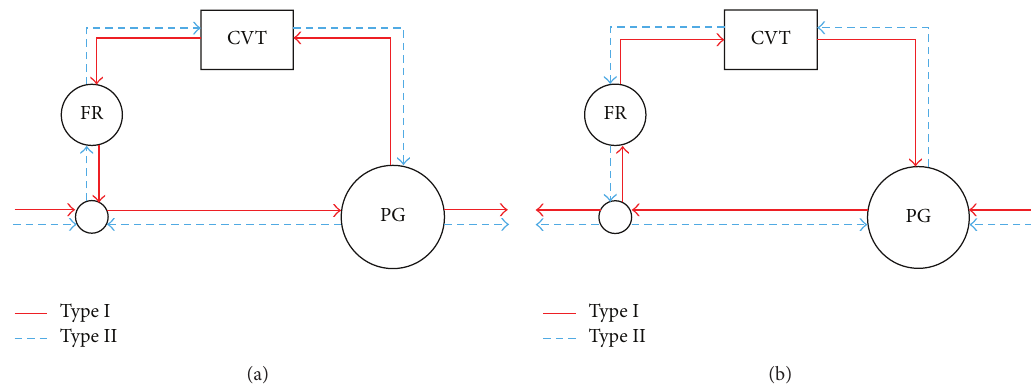
Figure 10: Schematic picture of the shunted CVT architecture of IVT, where power circulation of type I or that of type II can take place. Figures above depict the two types of power circulation in direct (a) and in reverse (b) operating